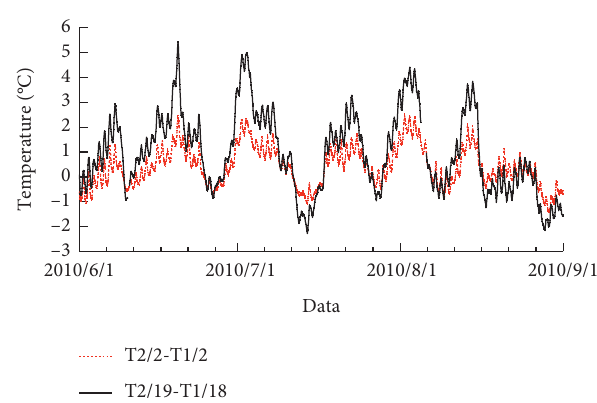
Figure 6: Longitudinal temperature difference in the web and bottom slab for the period from June 1 to August 31,